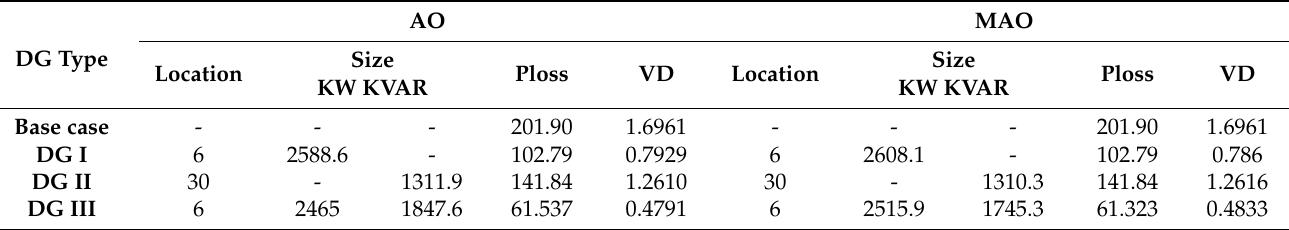
Table 13. Case 1: optimal DG allocation based on loss